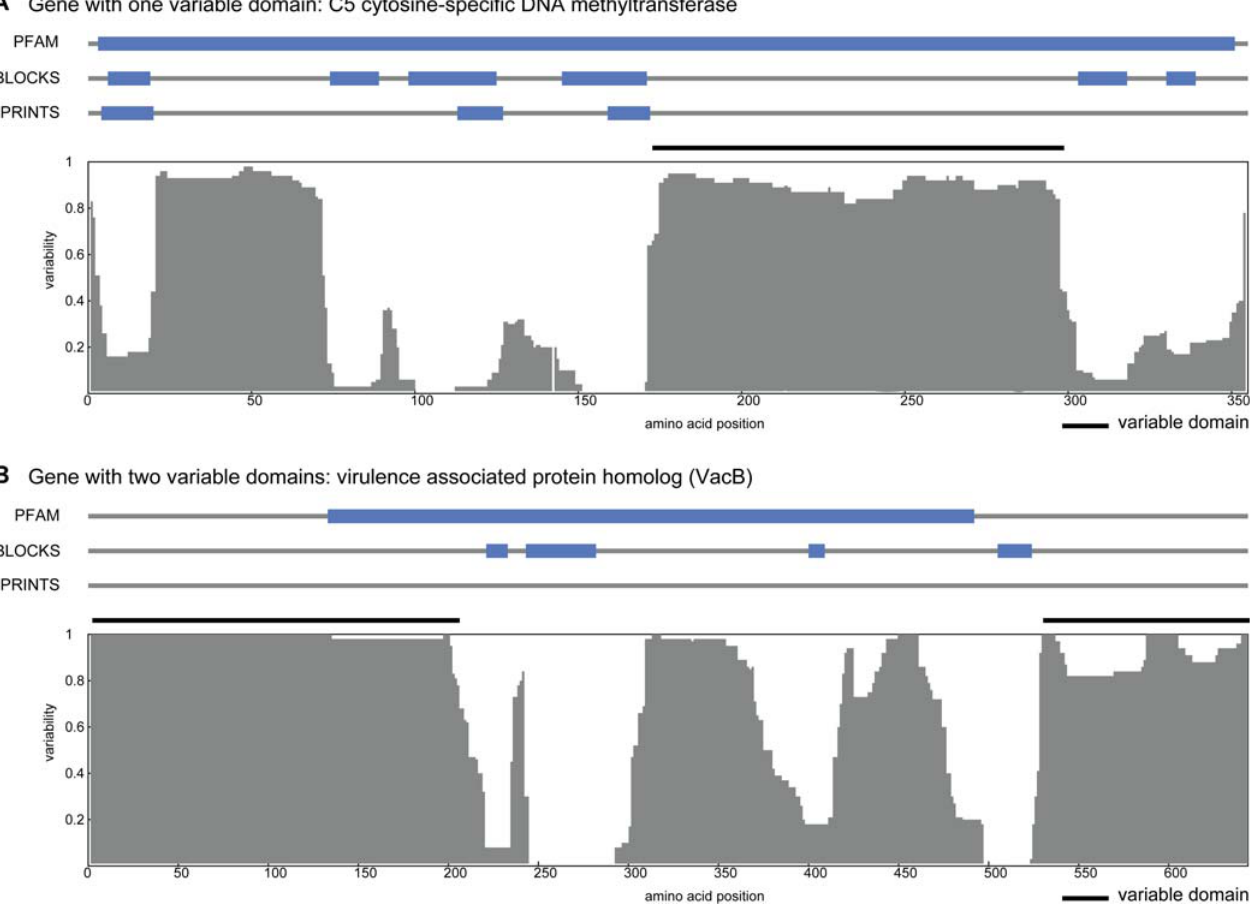
Figure 1. Variability Profile for Typical SVGs Blocks in the lines are conserved subsequences identified using the Pfam, BLOCKS, and PRINTS databases. In the variability profile, the x-axis is the amino acid position and the y-axis is the variability index (see Materials and Methods). Variable domains are marked by the black lines over the graph. (A) Cytosine-specific DNA methyltransferase of 355 amino acid long in H. pylori . Notice the variable domain in the middle and the variable segment in its N-terminal region, which is shorter than 70 amino acids and has no known function. (B) Virulence-associated protein homolog (VacB) of 644 amino acid long in H. pylori . It has two variable domains at the N- and C-termini. DOI: